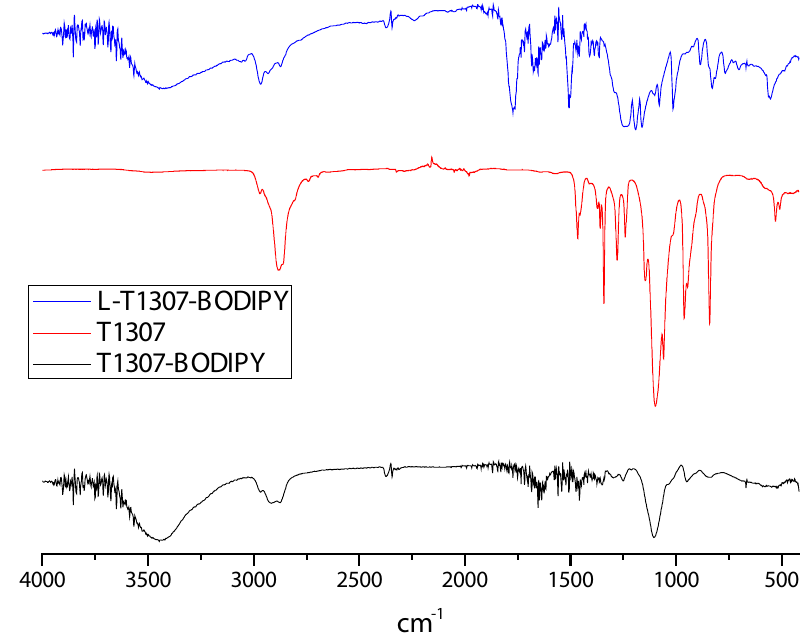
FIGURE 3 – FTIR spectra of T1307 (red), T1307-BODIPY (black) and L-T1307-BODIPY (blue).